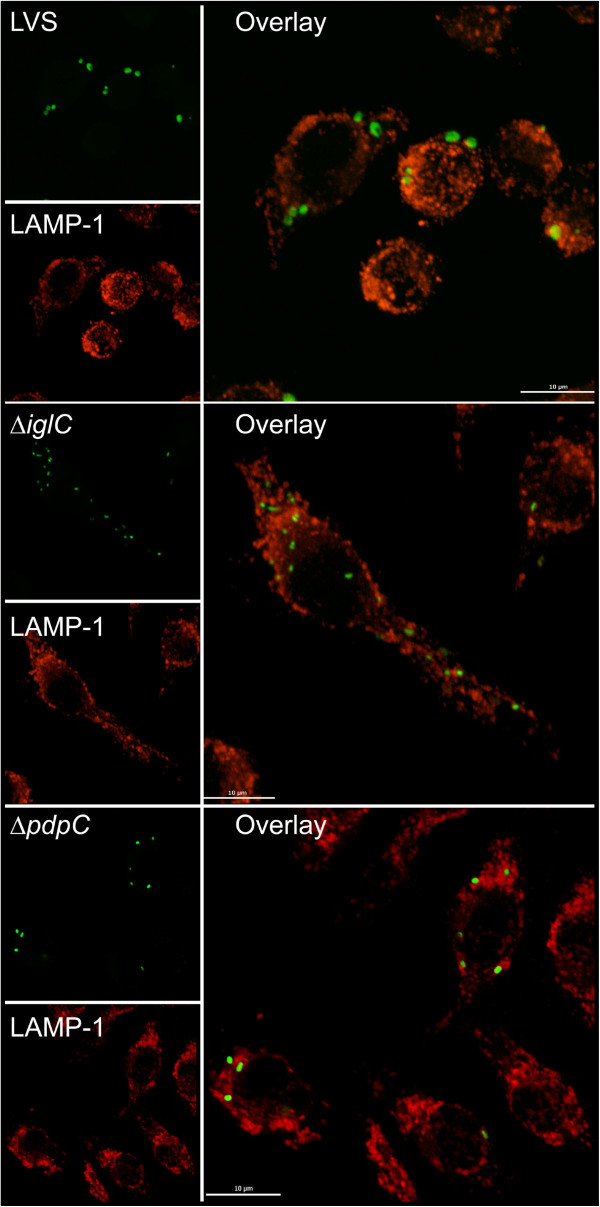
Colocalization of GFP-expressing F. tularensis strains and LAMP-1. J774 cells were infected with the LVS, the ΔpdpC mutant, or the ΔiglC mutant expressing GFP (Green fluorescent protein) at an MOI of 200 and, after washing, incubated for 6 h. Colocalization of GFP-labeled F. tularensis and LAMP-1 on fixed and labeled specimens was analyzed using a confocal microscope (Nikon Eclipse 90i, Nikon, Japan). Scale bar 10 μm.